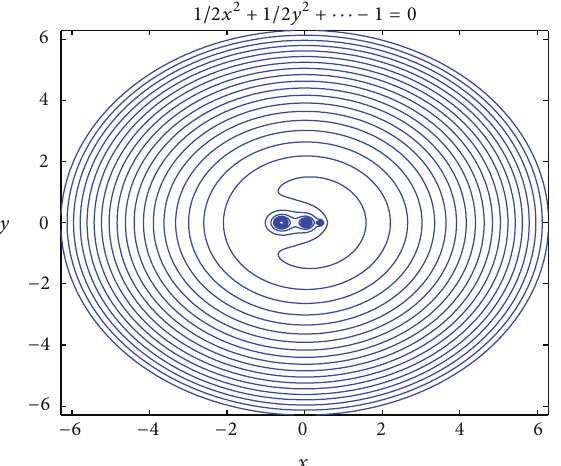
Figure 13: Curve of zero velocity ( 𝛼 CenAB-2) 𝑞 1 = 0.9971 , 𝑞 2 = = 0.01 , 𝐴 = 0.02 . 0.985 , and 𝐴 1 2